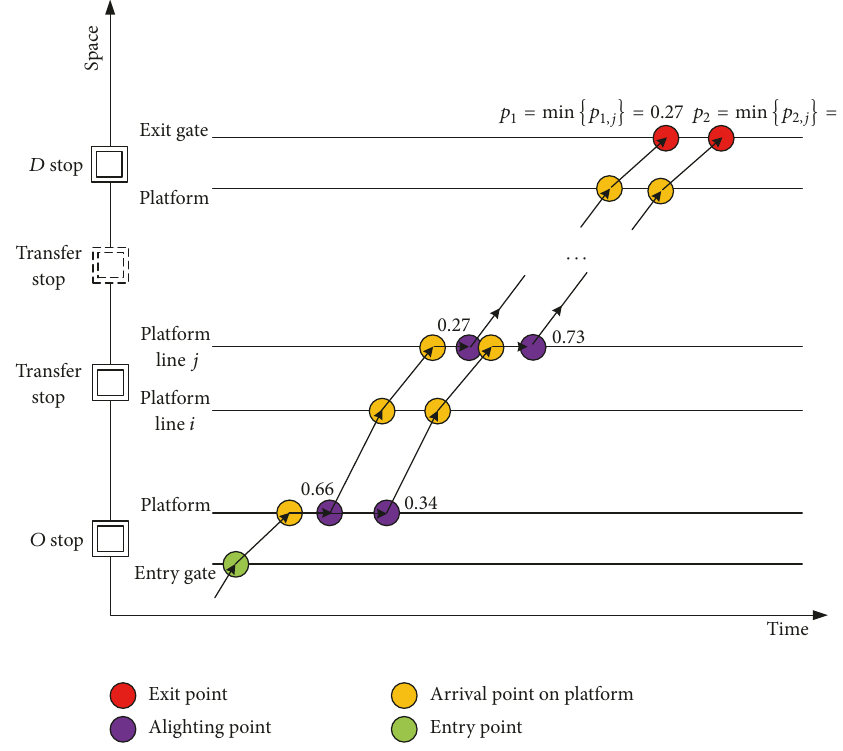
Figure 6: Illustration to choice probabilities of boarding